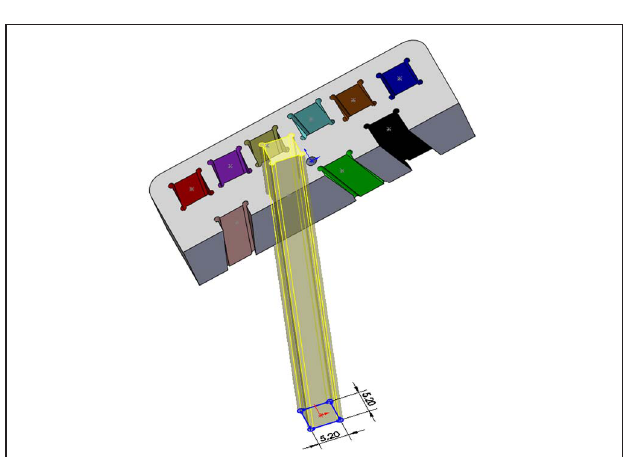
FIGURE 5 | The 5 × 5mm sketch used to project an extruded cut up through the grid insert. The sketch was slightly oversized (5.2 × 5.2mm), and circular grooves at the corners were added to facilitate introduction of